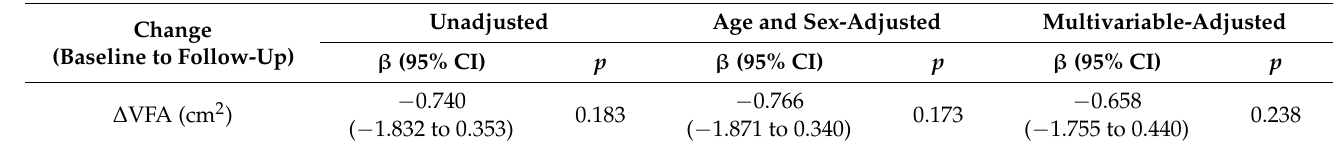
Table 4. Association between changes in catecholamine metabolites and changes in com- puted tomography-determined body composition before and after adrenalectomy in patients with